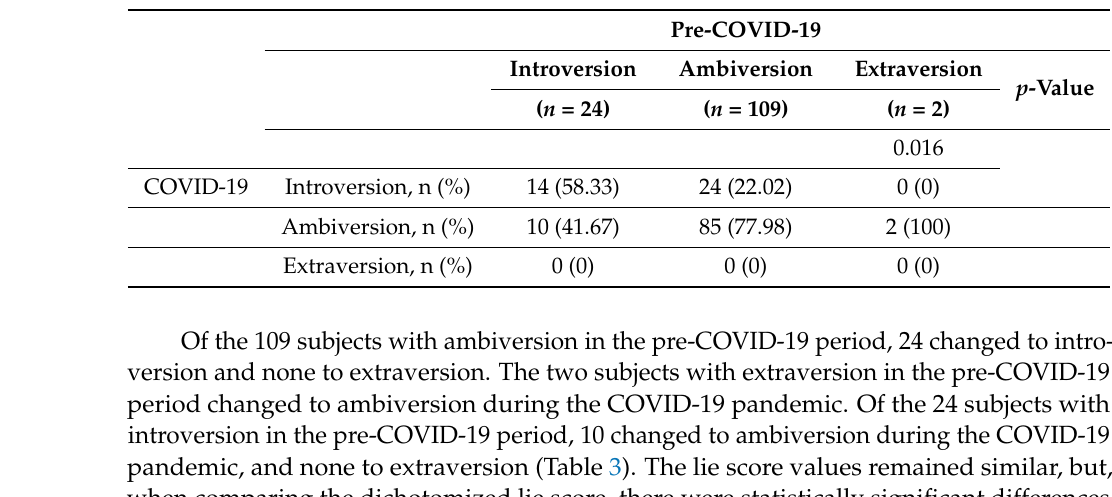
Table 2. Comparison of Eysenck Personality Inventory in the pre-COVID-19 versus the COVID-19 period.